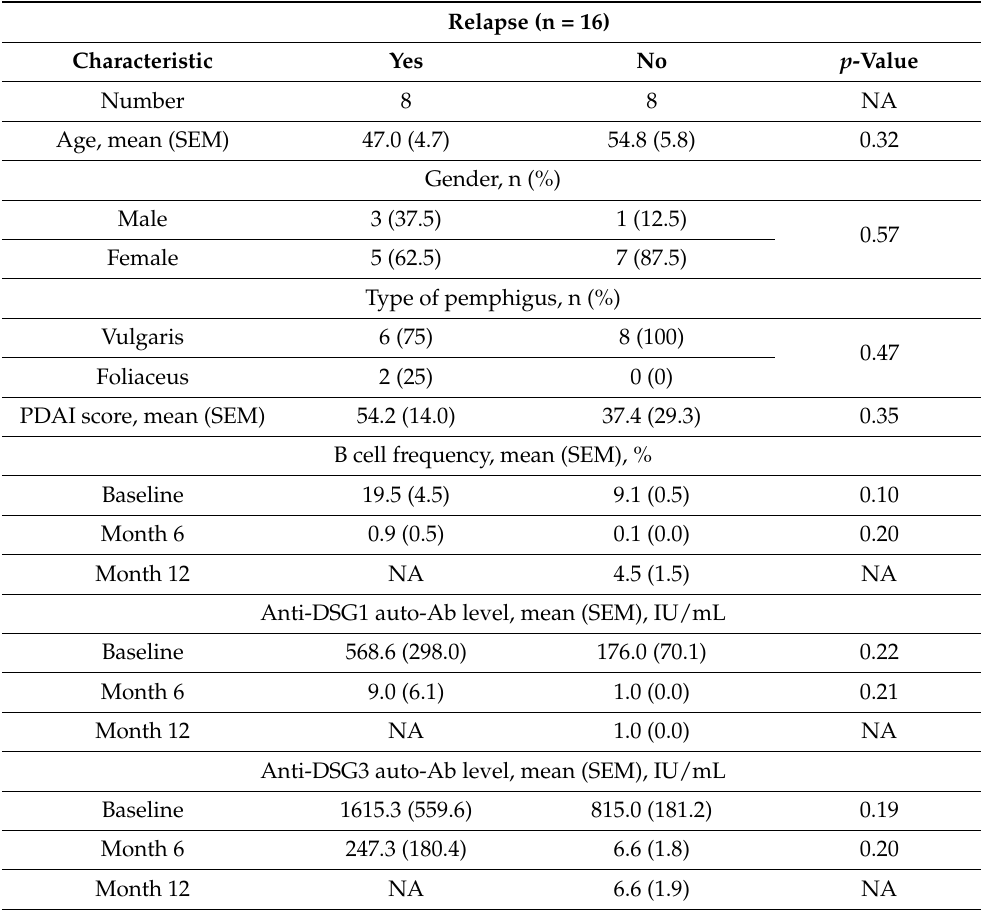
Table 1. Clinical and immunological characteristics of relapsing and non-relapsing patients at baseline and during the course of pemphigus. Auto-Ab: auto-antibody; DSG: desmoglein; IU: international units; NA: not applicable; SEM: standard error of the mean. Relapse (n = 16)